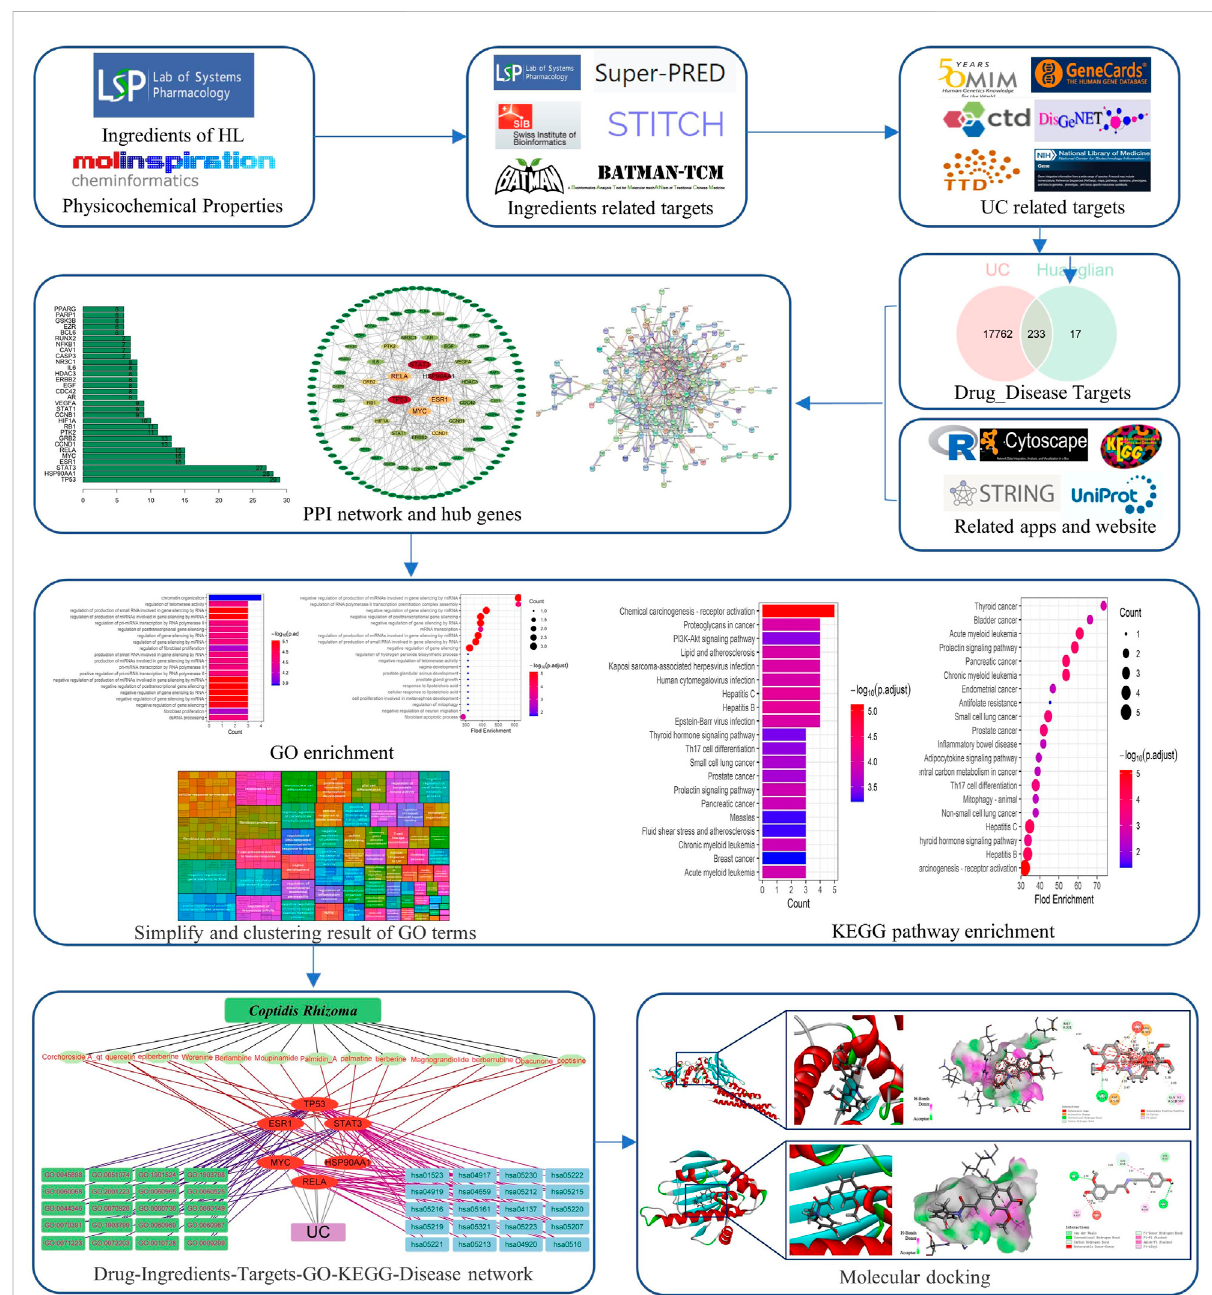
FIGURE 1 The fl ow diagram of this